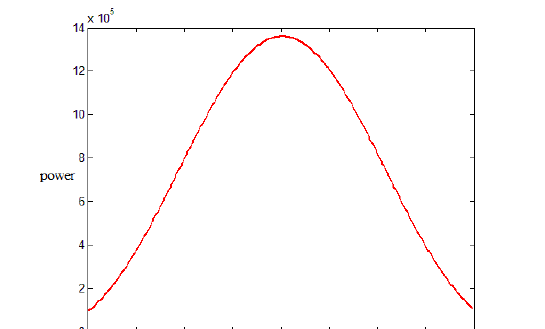
Figure.3 Quadratic Polynomial Antenna Pattern Fitting Graph